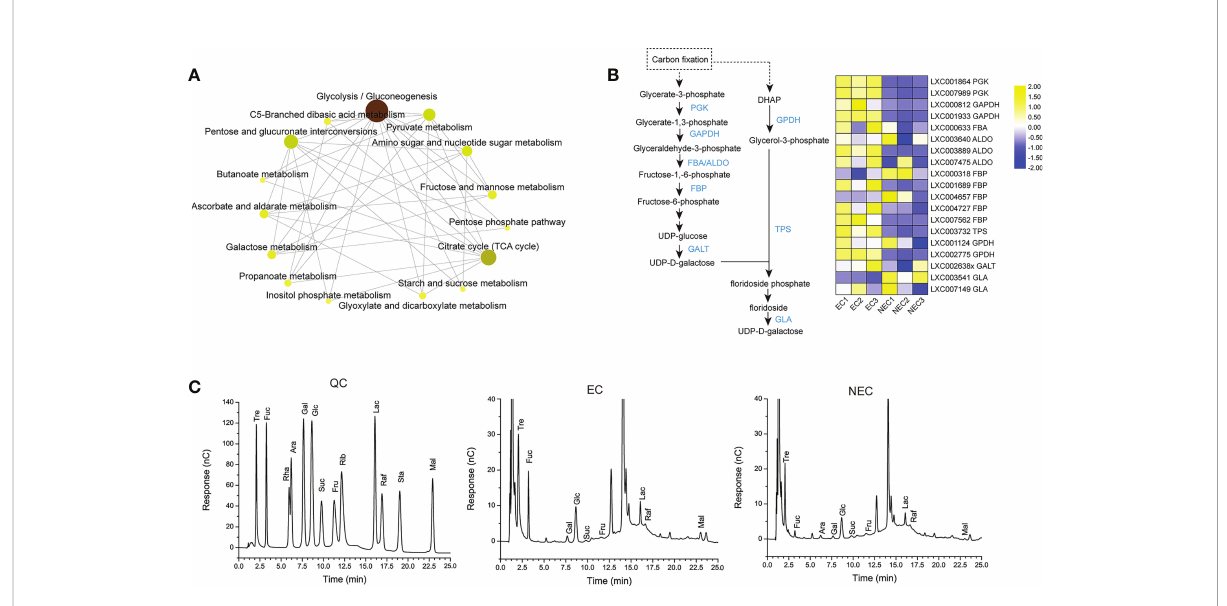
FIGURE 5 Low molecular weight carbohydrates (LMWC) metabolism in EC and NEC. (A) KEGG network map of 15 carbohydrate pathways enriched by differentially expressed genes (DEGs) of EC and NEC. The darker the color, the stronger the correlation between this pathway and other pathways. (B) Heat map displaying the expression level of some differentially expressed genes (DEGs) in glycolysis/gluconeogenesis pathway and fl oridoside metabolism pathway in EC and NEC. PGK: phosphoglycerate kinase, GAPDH: glyceraldehyde 3-phosphate dehydrogenase, FBA and ALDO: fructose-bisphosphate aldolase, FBP: fructose-1,6-bisphosphatase, GALT: galactose-1-phosphate uridylyltransferase, DHAP: dihydroxyacetone phosphate, GPDH: NAD-dependent glycerol-3-phosphate dehydrogenase, TPS: trehalose-6-phosphate synthase, GLA: a - galactosidase. (C) Chromatograms of soluble sugars in EC and NEC. X axis was the retention time and y axis was the response value. QC was the chromatogram of standard sample. Tre, Trehalose; Fuc, Fucose; Rha, Rhamnose; Ara, Arabinose; Gal, Galactose; Glc, Glucose; Suc, Sucrose; Fru, Fructose; Rib, Ribose; Lac, Lactose; Raf, Raf fi nose; Sta, Stachyose tetrahydrate; Mal,